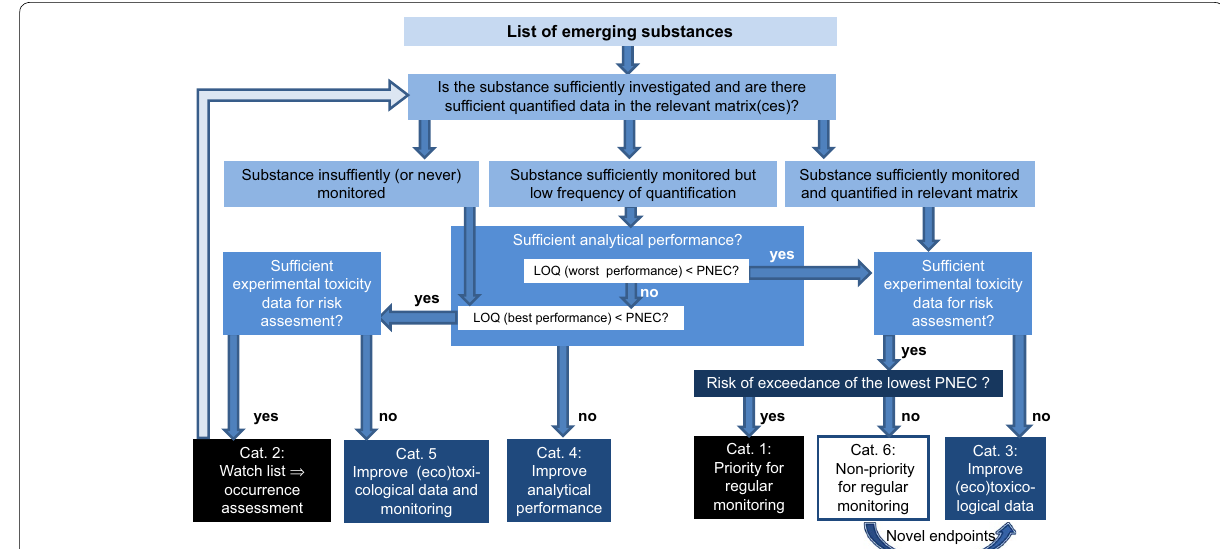
Fig. 2 Prioritization scheme of the NORMAN